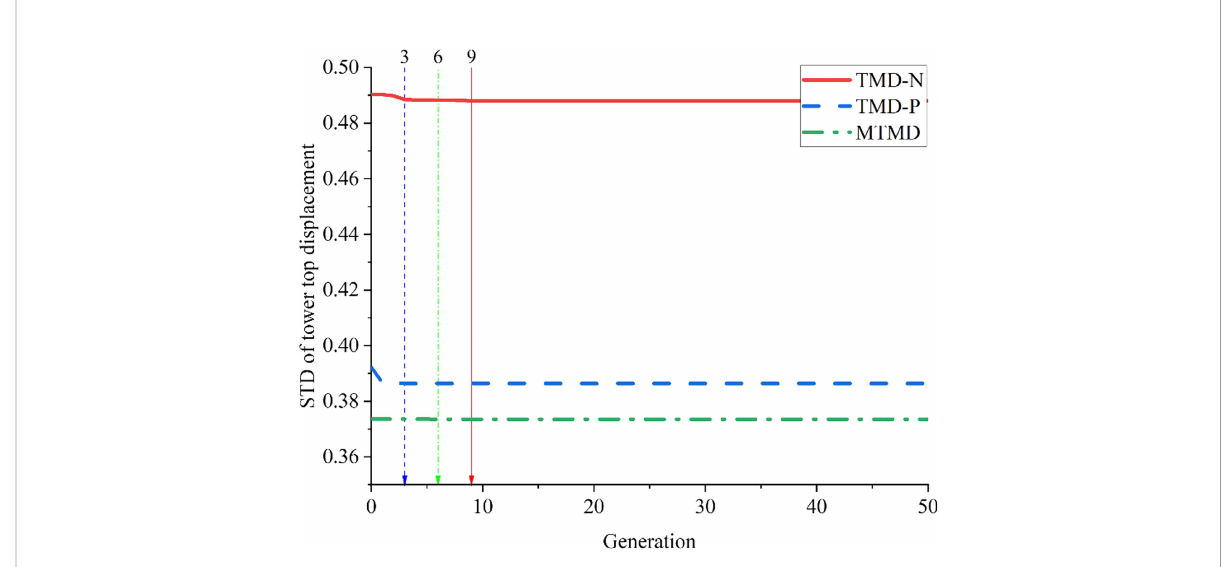
FIGURE 6 Convergence curves of the fi tness function for parameter optimization of different TMD con fi gurations.